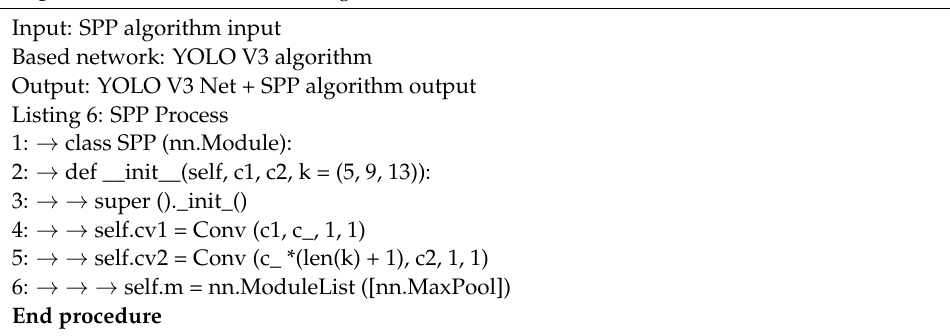
Algorithm 6 : YOLO V3 + SPP